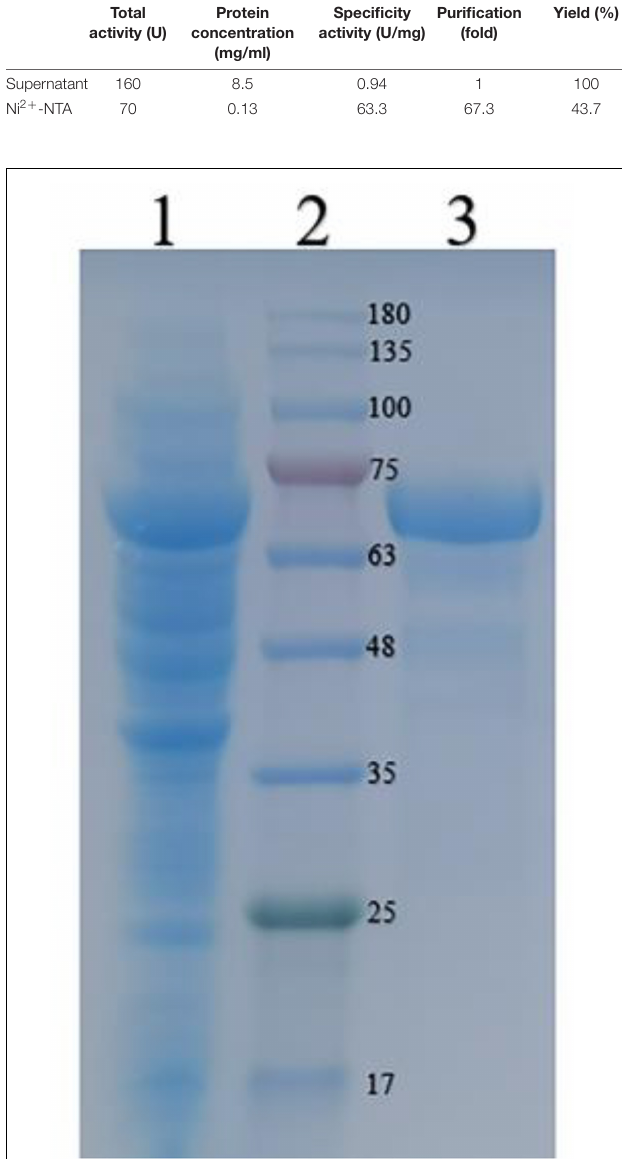
FIGURE 2 | Sodium dodecyl sulfatepolyacrylamide gel electrophoresis (SDS-PAGE) analyses of the recombinant CGTase on a 12% gel. Lane 1 crude CGTase, lane 2 protein marker, and lane 3 purified